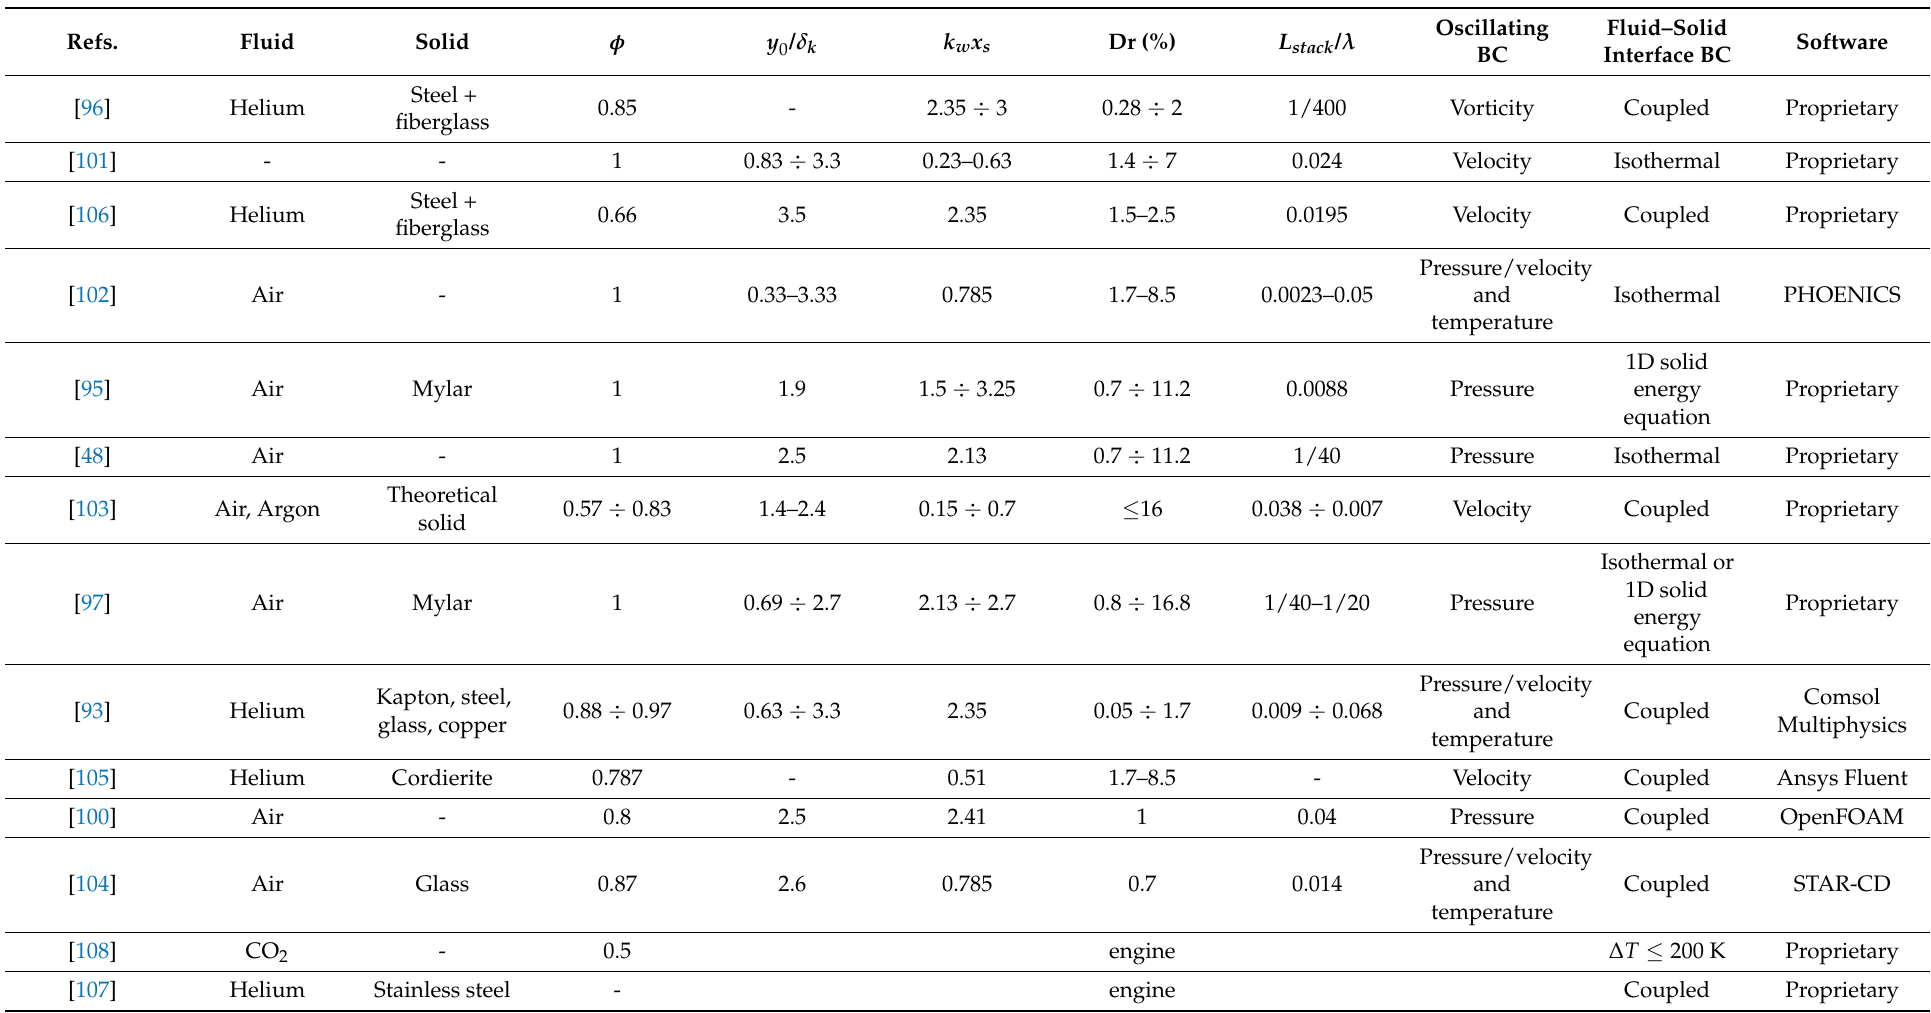
Table 2. Detailed characteristics of simulations of single TACs.